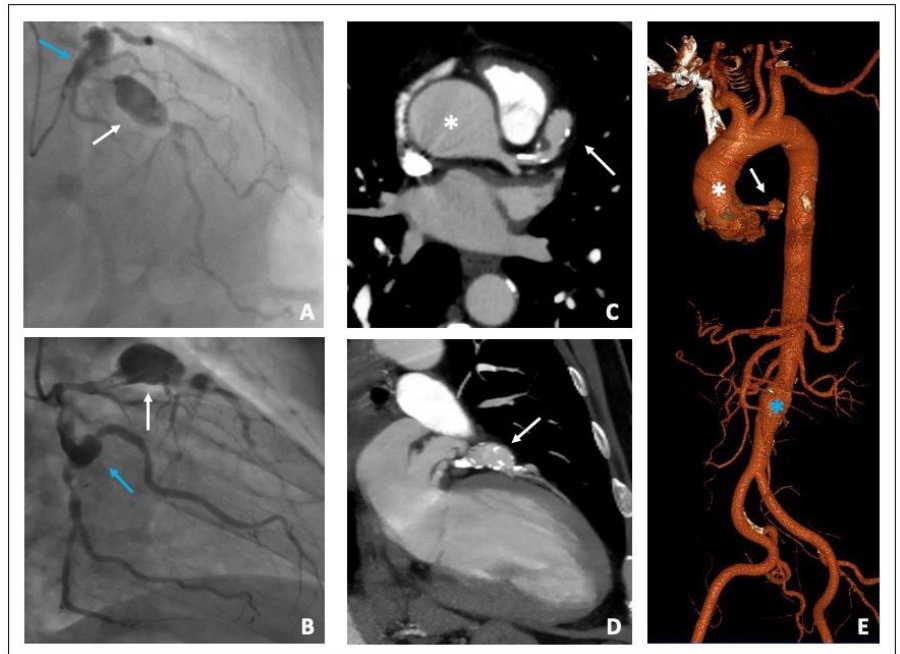
Figure 2. (A , B ) Coronary angiography. ( A ) Proximal LAD giant aneurysm (white arrow) followed by a severe stenosis. Proximal left circumflex artery ectasia (blue arrow). ( B ) Proximal left circumflex artery ectasia (blue arrow) followed by a severe stenosis of the distal segment. Proximal LAD giant aneurysm (white arrow) ( C , D ) MSCTA Cardiac short and long axis view showing both ascending aorta (white asterisk) and LAD aneurysms (white arrow). ( E ) 3D aortic reconstruction image: As- cending (white asterisk) and infra-renal aortic aneurysms (blue asterisk) and LAD aneurysm (white arrow). LAD (left anterior descending); MSCTA (multi-slice computed tomography angiography).